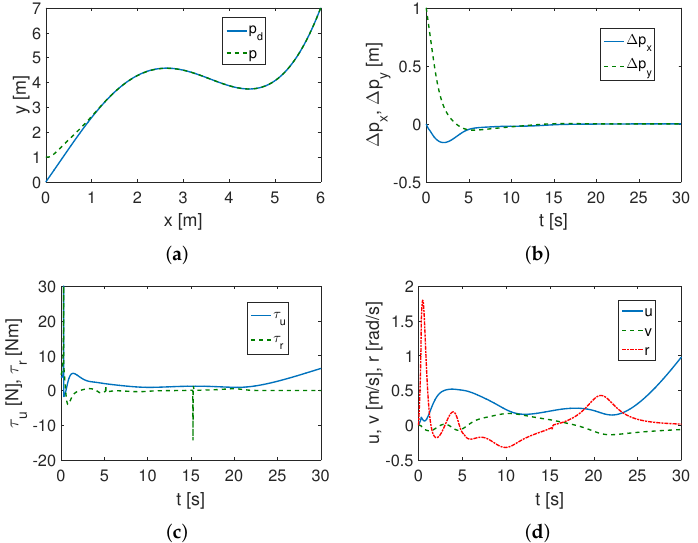
Figure 7. Simulation results for TSMC and complex trajectory (without friction): ( a ) desired ( p d ) and realized ( p ) trajectory; ( b ) position errors ∆ p x , ∆ p y (in inertial frame); ( c ) input signals components (applied force and torque) τ u , τ r ; ( d ) actual velocities u , v , r . Table 3. Performance for TSMC